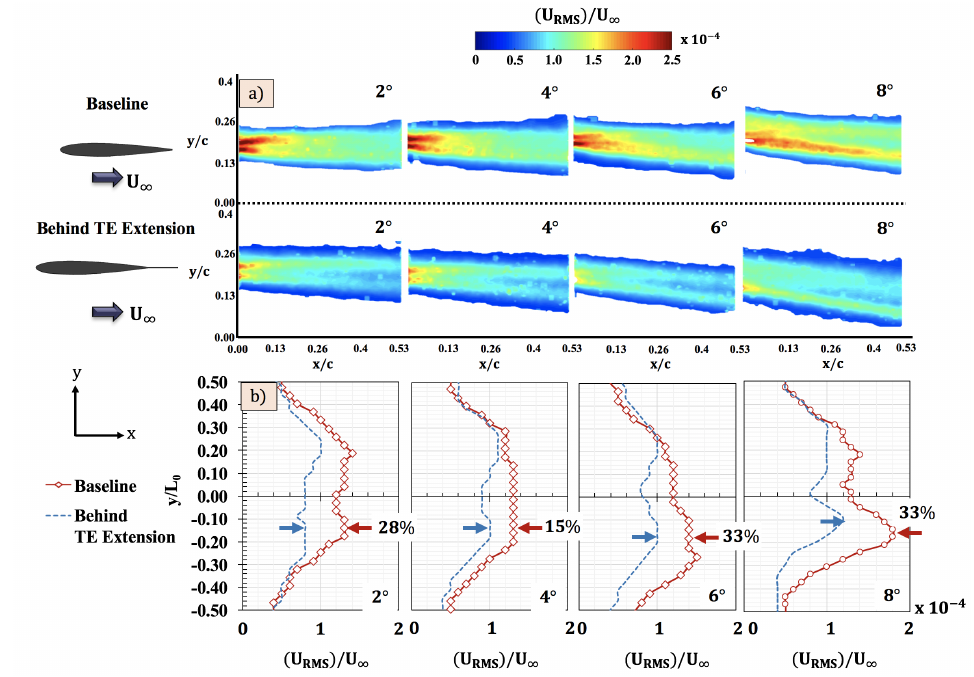
Figure 19. ( a ) Streamwise U RMS contours in FSL behind the trailing edge of the NACA 0012 wing and behind the TE extension. ( b ) U RMS profiles at different angles of attack for both cases. Large decreases were observed in the U RMS of the TE